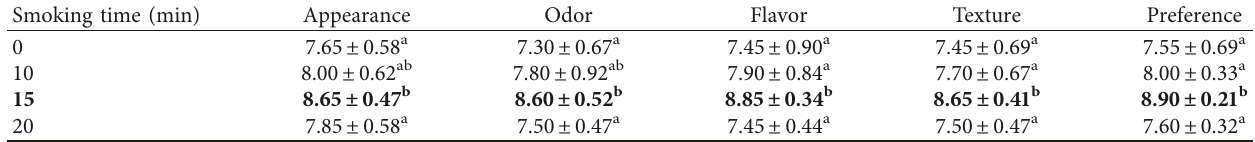
Table 7: Sensory evaluation of oak sawdust-smoke-treated squid at different time durations.